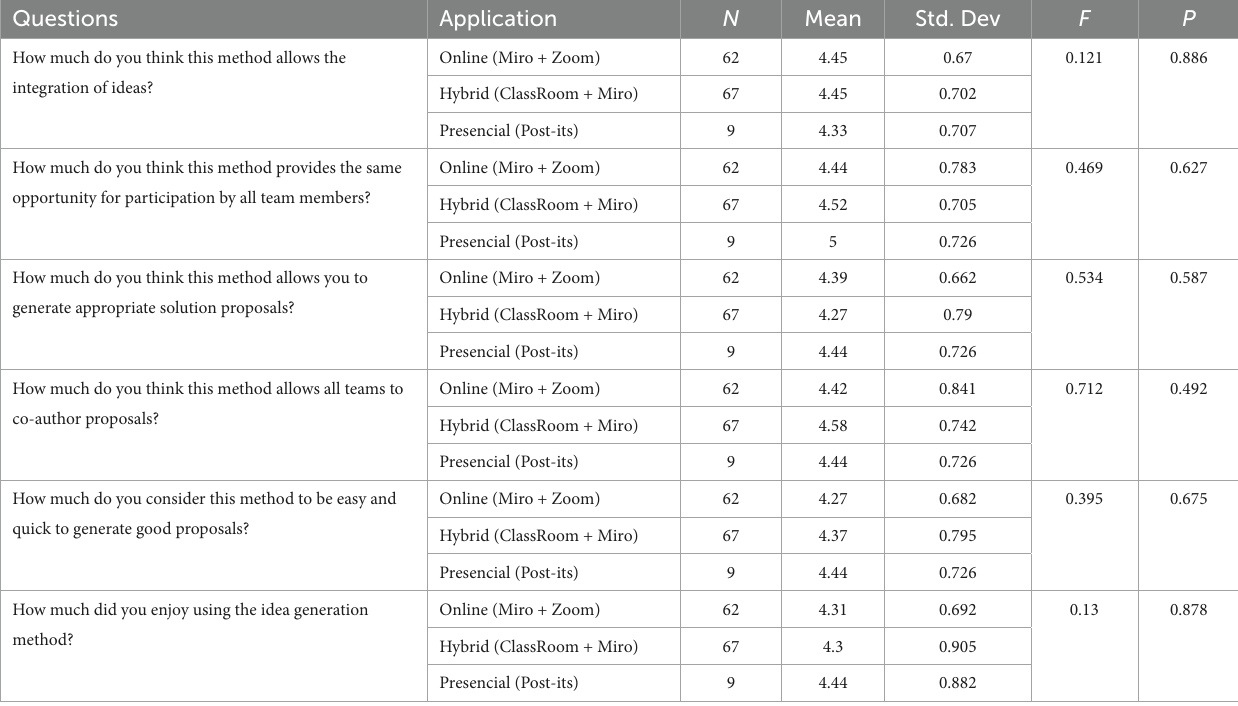
TABLE 5 Descriptive statistical and ANOVA for method application.